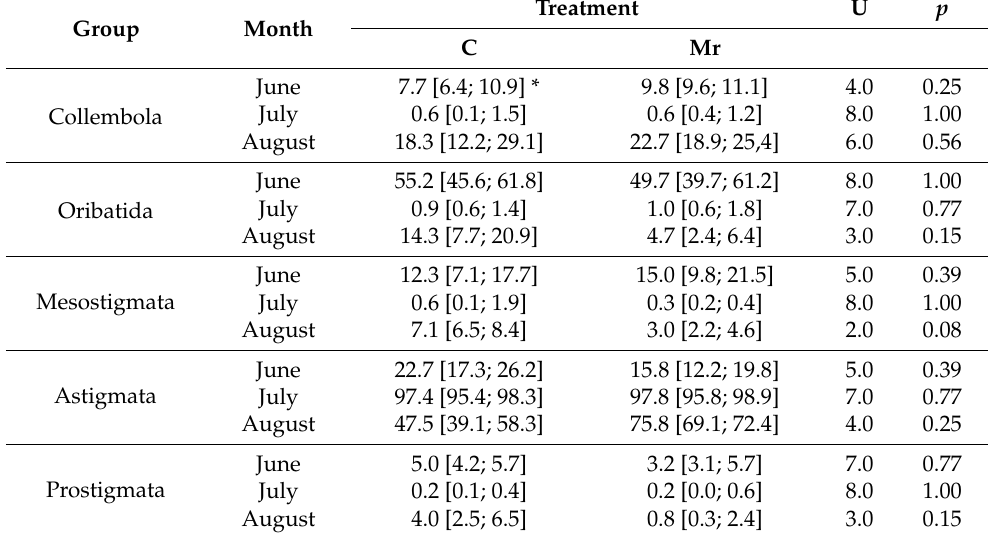
Table 5. Results of comparative analysis of the proportion of individual groups in the community in the plots with different types of seed treatment in 2019 (Mann–Whitney test).